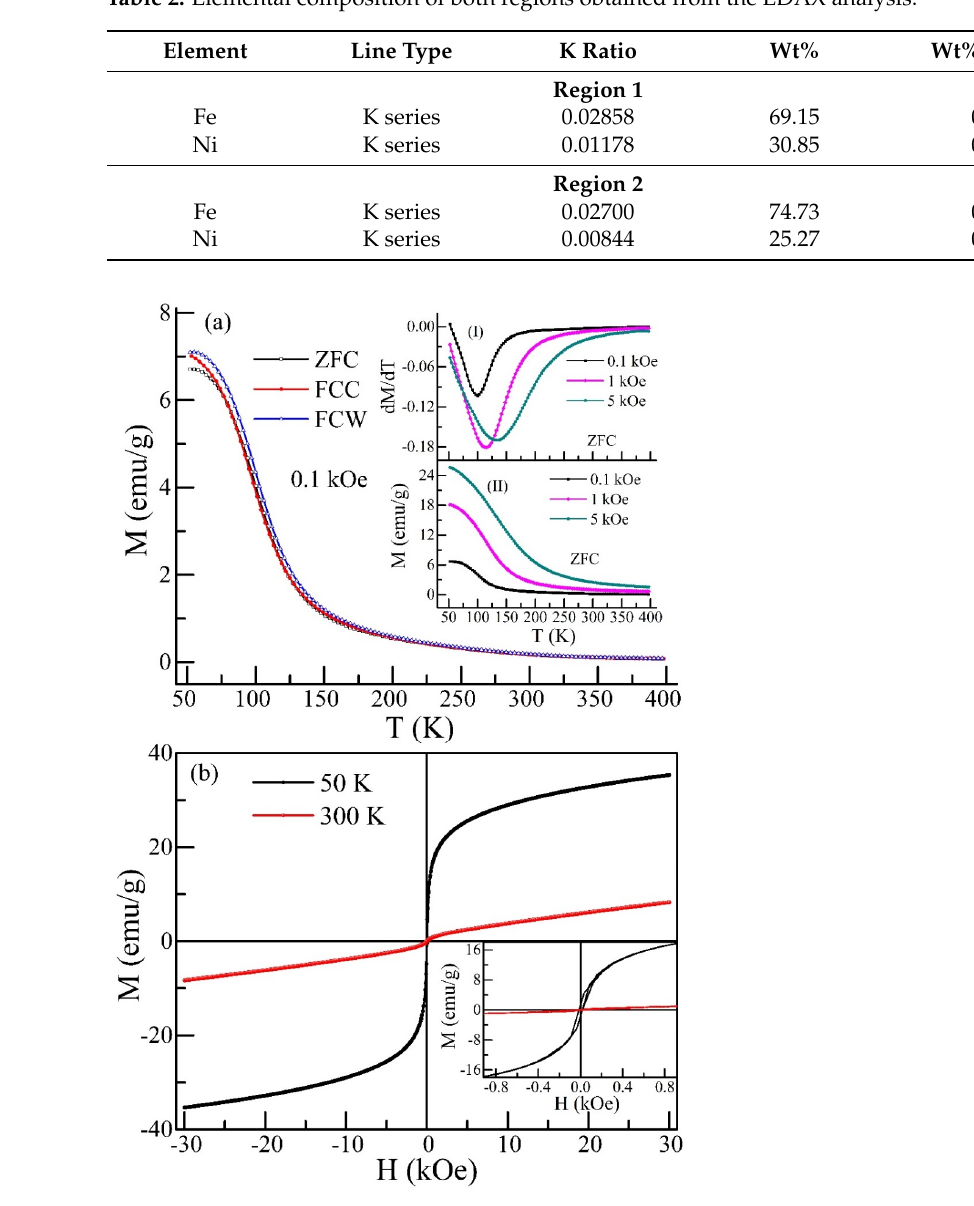
Table 2. Elemental composition of both regions obtained from the EDAX analysis.